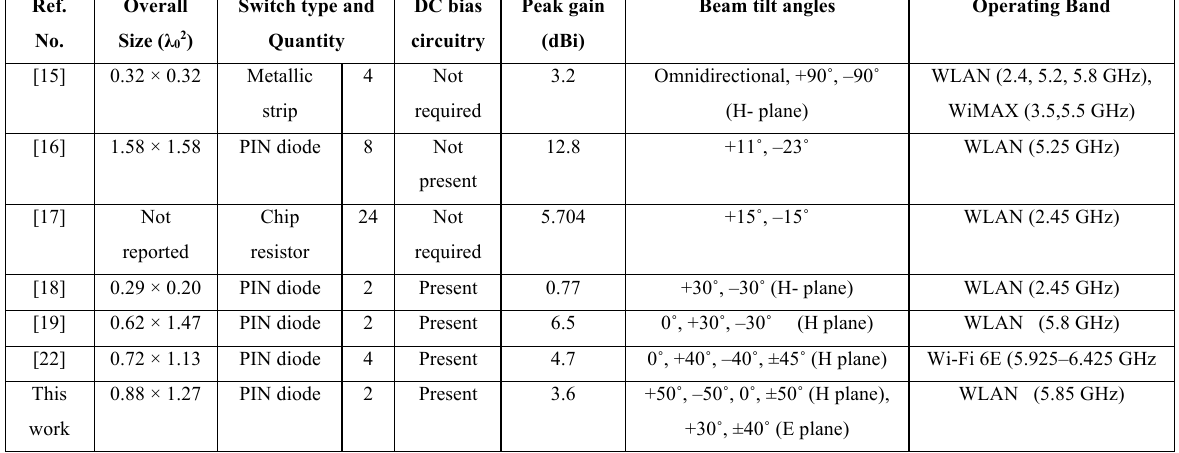
TABLE IV. Comparison of the proposed PRPA with other relevant works ( λ 0 = free space wavelength at lowest resonant frequency).